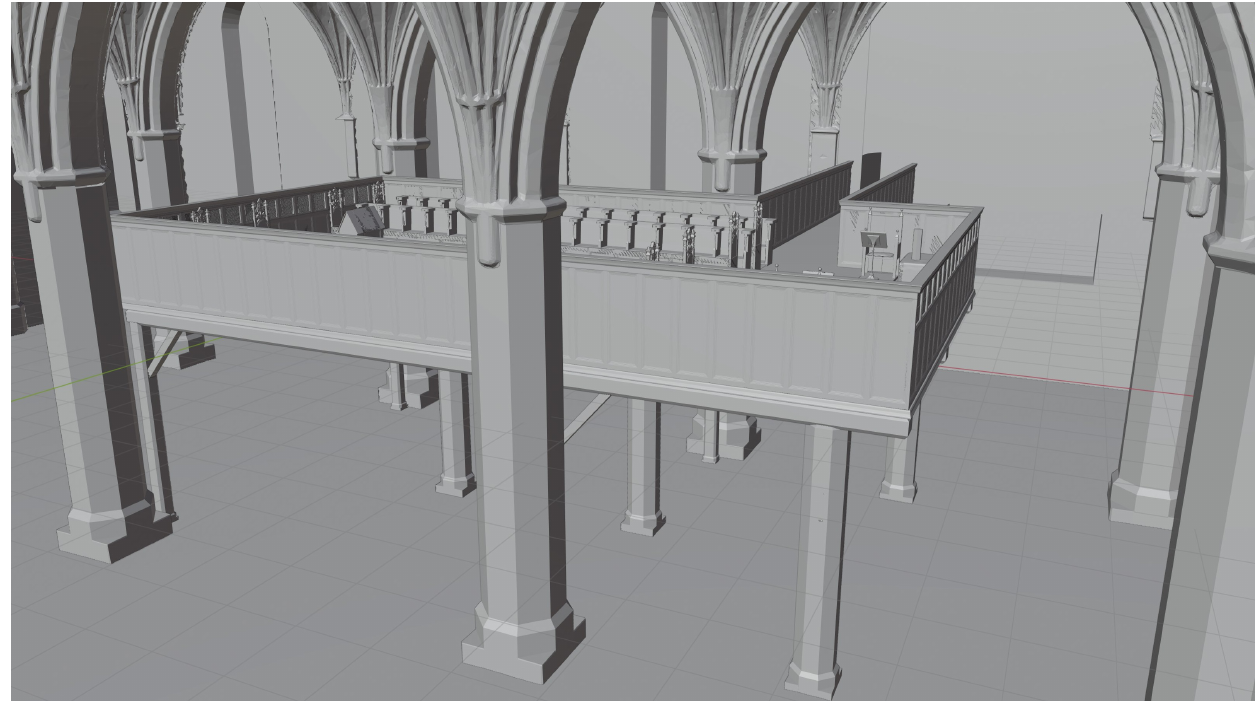
Figure 4. 3D model of the nuns’ gallery (other nave elements mentioned in the text are not visualized here), showing the entrance niche in the northern wall, leading through a crossing to the gallery. The panels on the shorter sides have small windows for visual access. The gallery is supported from beneath by four brick pillars. View from south to